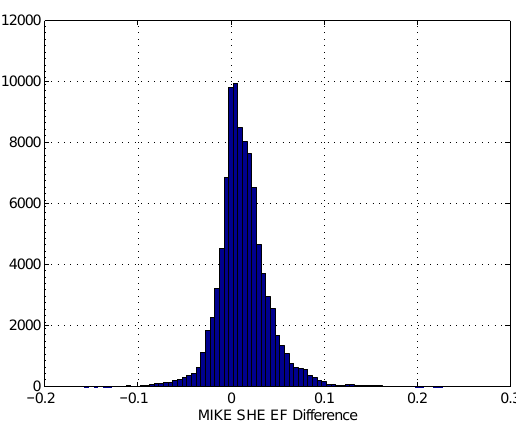
Figure 6. Histogram of the pixel-wise differences between evap- orative fraction (EF) estimated by MIKE SHE at the time of Aqua overpass and Envisat overpass. The differences between the two sets were evaluated using the two-sample t test and are found to be sta- tistically significant with a p value smaller than